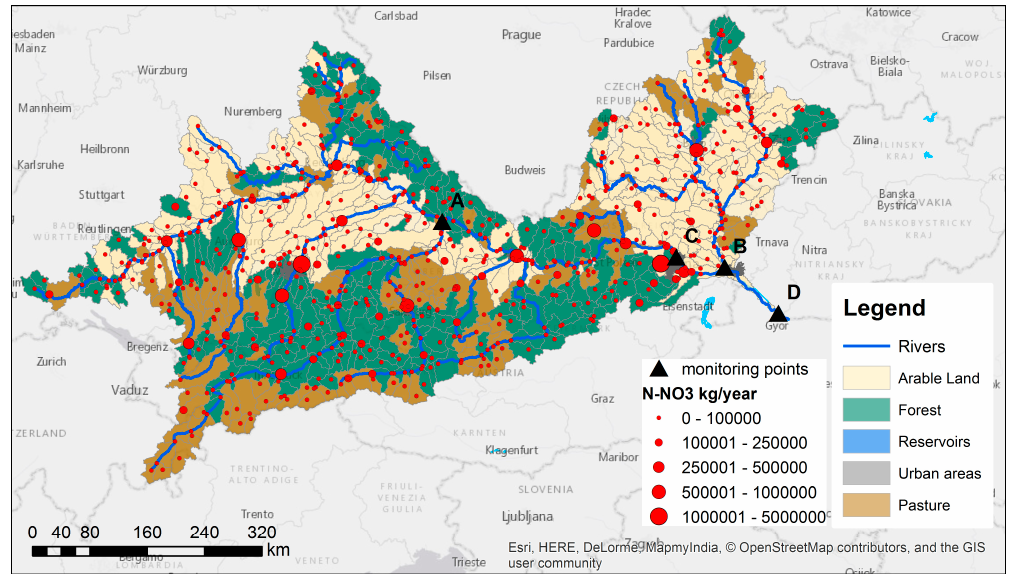
Figure 1. The Upper Danube watershed with the distribution of the main classes of land cover, main rivers and N ‐ NO 3 annual loads from point sources. The letters A ‐ B ‐ C ‐ D indicate the location of four stations for which time ‐ series of N ‐ NO 3 concentrations in the rivers are provided in Figure 3.